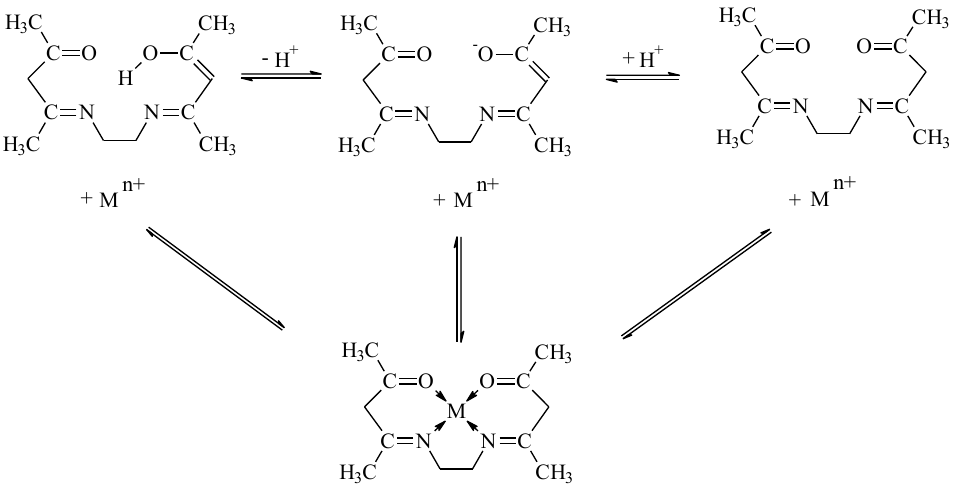
Figure 7. Scheme of EDAB-acac -metal ion complexation. Table 4. Initial fluxes, order and separation coefficients for competitive transport of Zn(II), Cr(III) and Ni(II) ions through membrane doped with EDAB-acac. Conditions as in Figure 6.